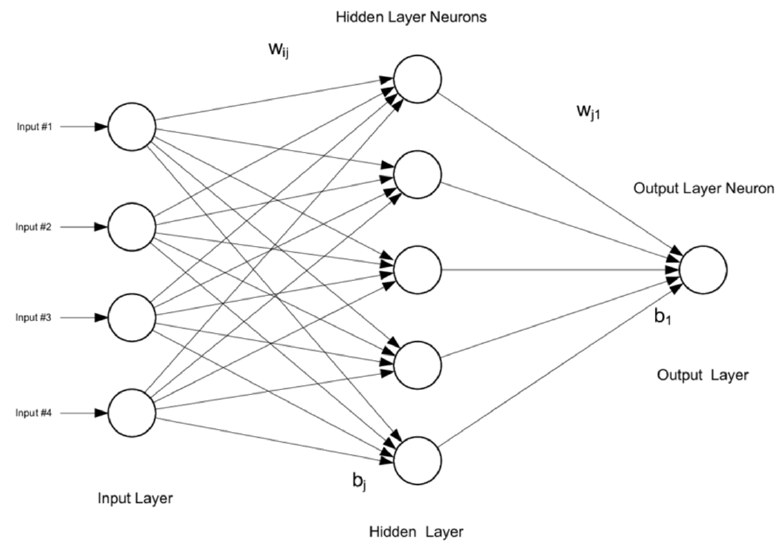
Figure 9. Multilayer artificial neural network [42].